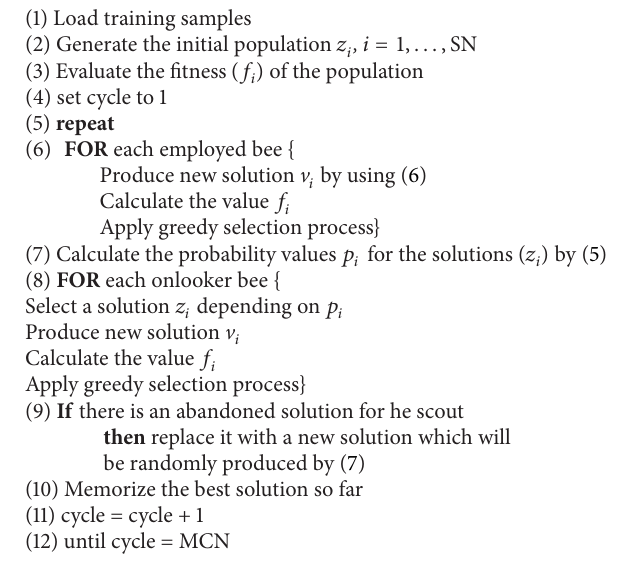
Pseudocode 2: Pseudo-code of the ABC algorithm